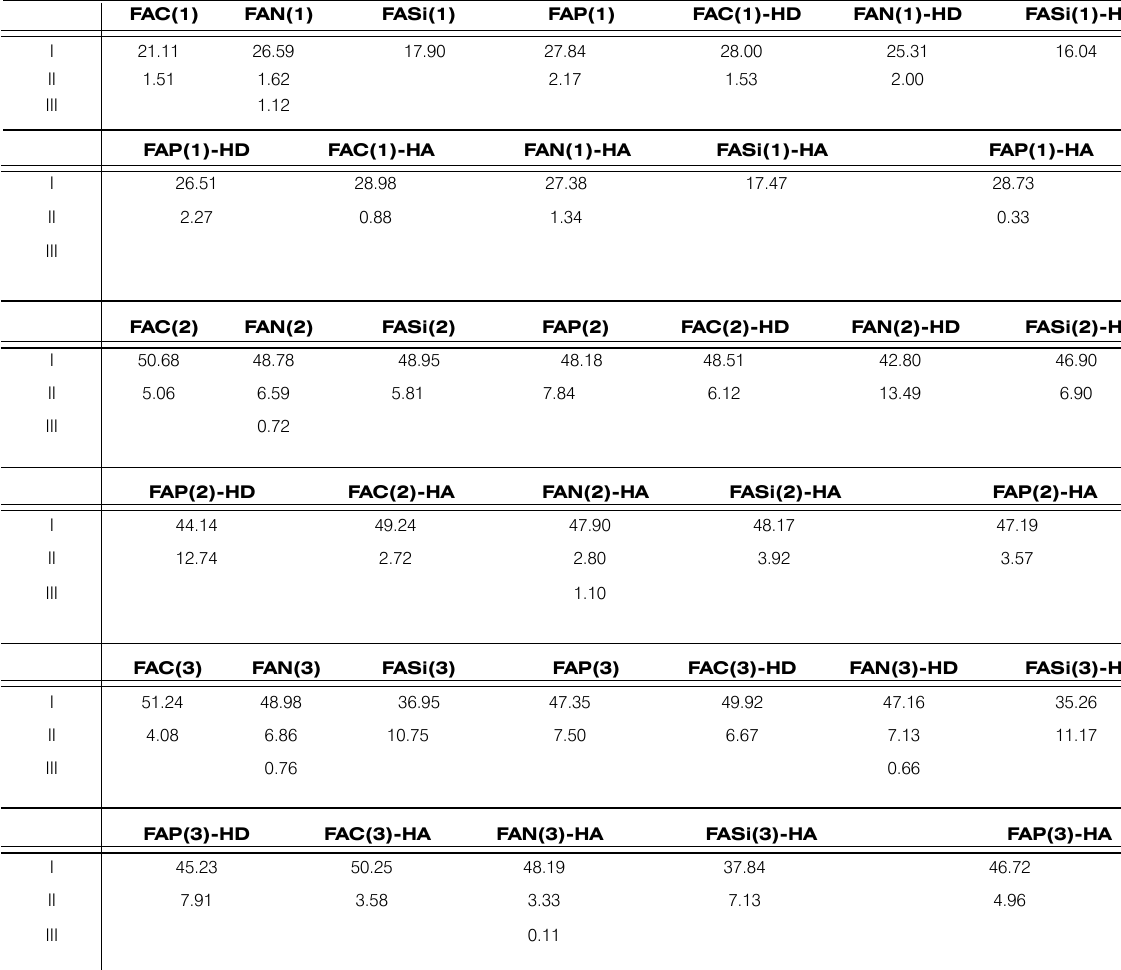
Table 1. Weights of resonance I, II, and III in Scheme 1 at MP2/aug-cc-pVTZ//MP2/cc-pVTZ level by NRT.